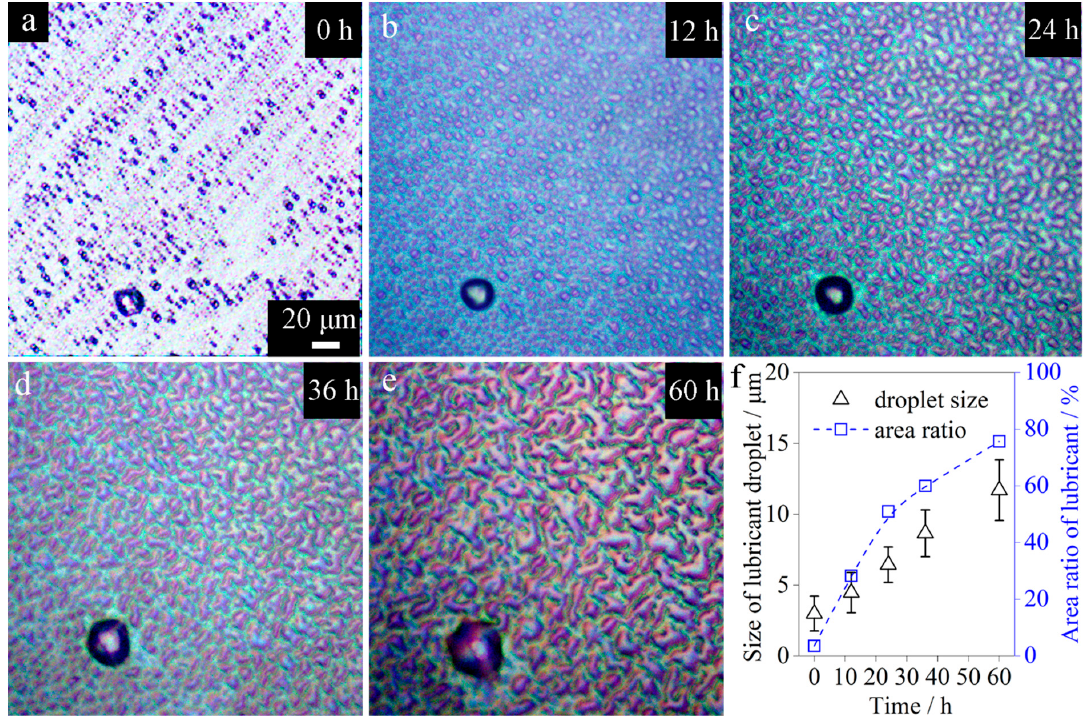
Figure 4. ( a – e ) In situ observation of lubricant releasing process of 30% sample at 20 °C. ( f ) Size of lubricant droplet and area ratio of lubricant on surfaces as a function of time.